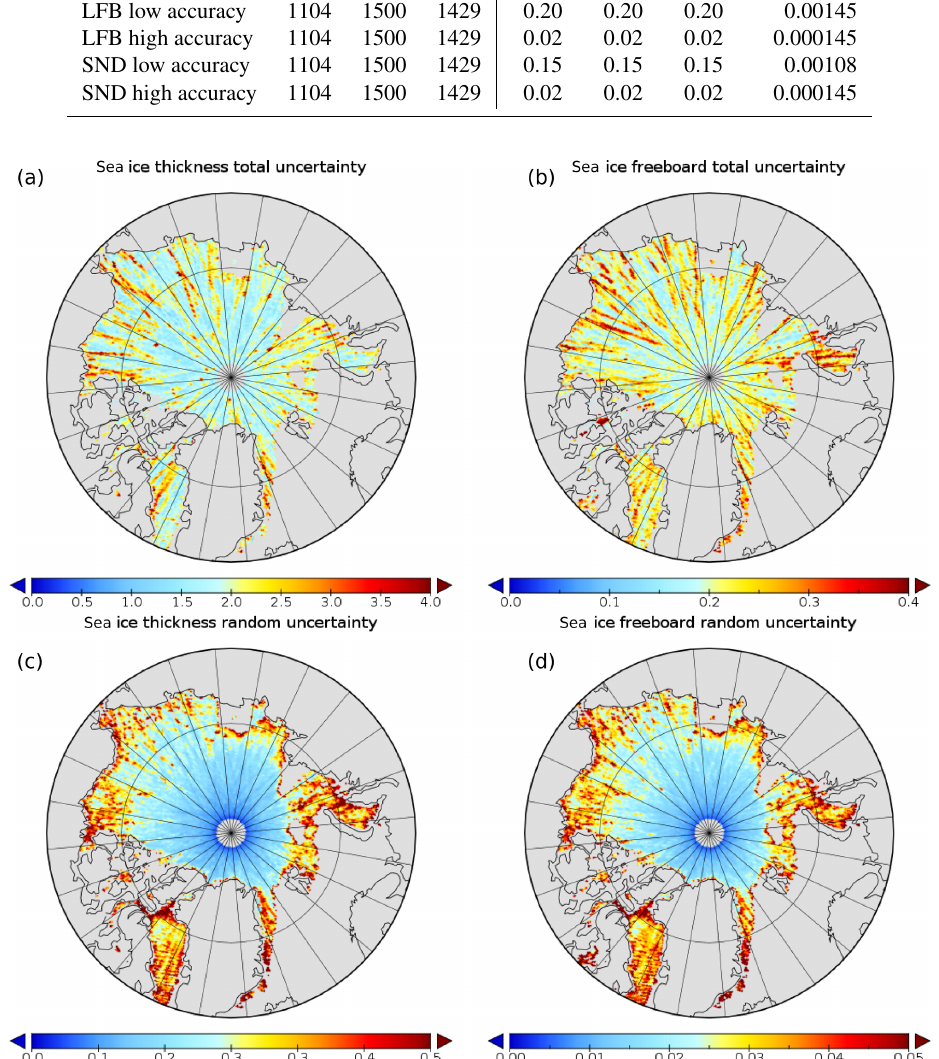
Figure 13. Uncertainty ranges (m) of CryoSat-2 products for April 2015: SIT (a, c) , SIFB (b, d) , total uncertainty (a, b) , and random uncertainty (c, d)